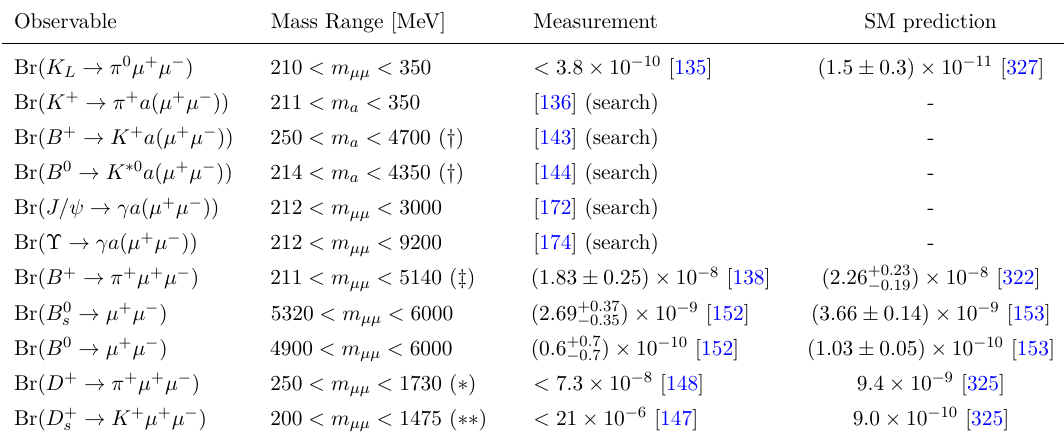
Table 6 . Observables with a muon pair in the final state. Bounds are at 90% CL. ( † ) : cuts are applied to exclude regions around the J/ψ , ψ (2 S ) and ψ (3370) resonances. ( ‡ ) : cuts are applied to exclude charmonium resonance regions ( 8 . 0 < m 2 15 . 0 GeV 2 are excluded). ( ∗ ) : a large region containing the η , ρ/ω and φ resonances is excluded ( 525 < m 1250 MeV). ( ∗∗ ) : cuts are applied to exclude the region around the φ resonance µµ < ( 990 < m 1050 MeV). Since the long-distance contributions to the D µµ < excluded resonance(s), we take the SM prediction to be only due to the short-distance contributions, as calculated in ref. [325].